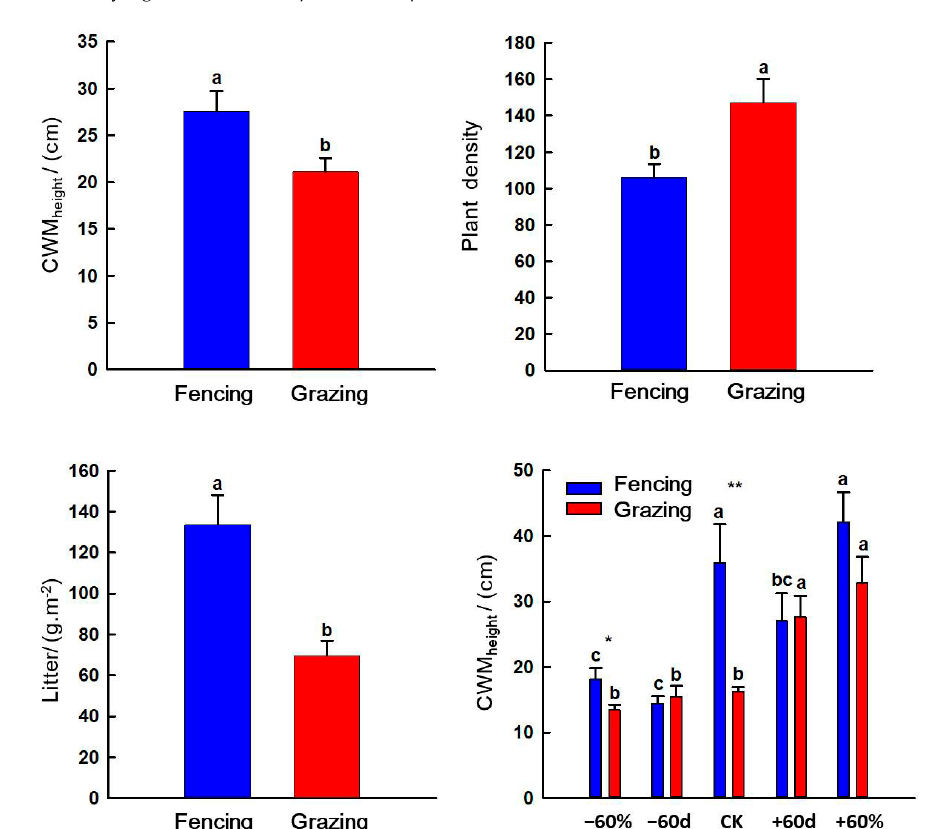
Figure 6. Effects of grazing on vegetation characteristics in the sandy grassland. Note: Different little letters indicate significant differences among grazing and fencing ( p < 0.05). * indicates significant differences between grazing and fencing treatment under specific rainfall treatments ( p < 0.05); ** indicates extremely significant differences between grazing and fencing treatment under specific rainfall treatments ( p < 0.01).